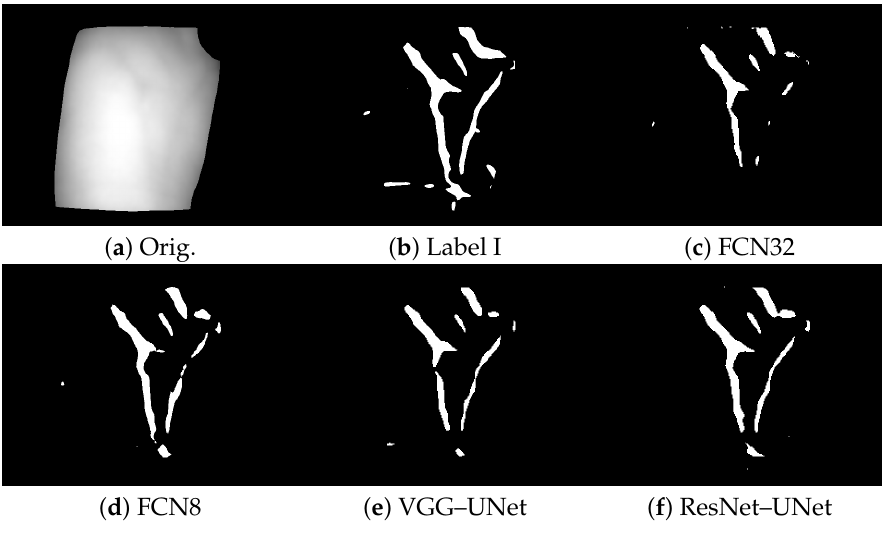
Figure 18. Segmentation results of the networks